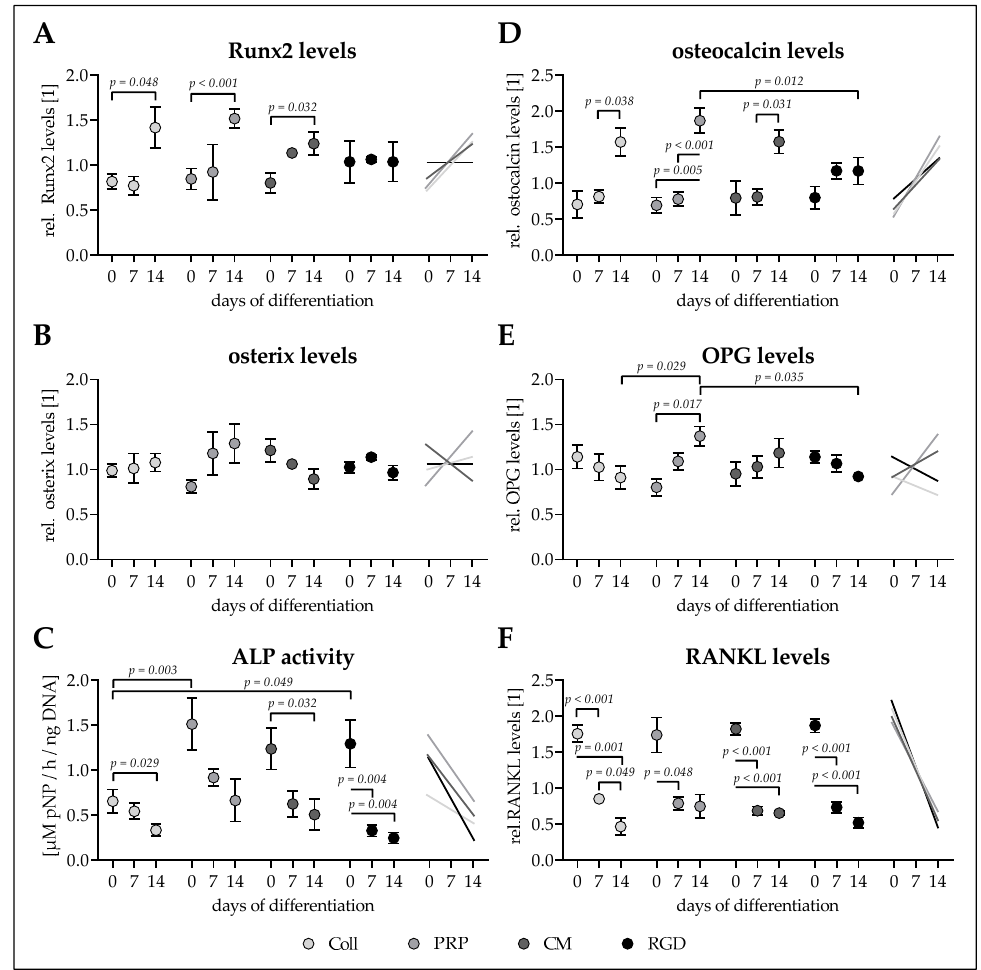
Figure 5. Osteogenic characteristics of Ad-MSCS di ff erentiated for 14 days on the four di ff erent cryogels. Adipose-derived mesenchymal stem cells (Ad-MSCs) were osteogenically di ff erentiated for 14 days on cryogels containing 16% pHEMA, crystallized calcium–phosphate, and collagen (Coll), platelet-rich plasma (PRP), immune-cell conditioned medium (CM), or RGD peptides (RGD). On days 0, 7, and 14 intracellular ( A ) Runt-related transcription factor 2 (Runx2) and ( B ) and osterix were determined by dot blot. ( C ) Alkaline phosphatase (ALP) activity on days 0, 7, and 14 of di ff erentiation normalized to the total DNA contents. On days 0, 7, and 14 secreted levels of ( D ) osteocalcin, ( E ) osteoprotegerin (OPG), and ( F ) receptor activator of nuclear factor kappa-B ligand (RANKL) were detected in the culture supernatants by dot blot. Data are presented as floating signs (mean ± 95% C.I.) of N ≥ 3 ( n ≤ 3) individual experiments.